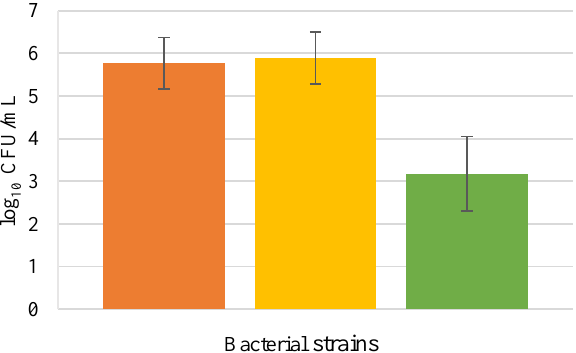
Figure 2. Probiotic bacteria invasion of HaCat cells in Lacticaseibacillus rhamnosus ( ■ ), Lactobacillus delbrueckii subsp. bulgaricus ( ■ ), and Propioniferax innocua ( ■ ). Error bars are ± standard deviation. In co-cultures (Figure 3), E . coli showed no ability to invade keratinocytes in the pres- ence of probiotic bacteria; but this result could be related to the inoculum concentration. The initial counts were higher and the obtained values for E . coli invasion were not detectable (below the method’s detection limit). However, also, the possible probiotic inhibition effects on E. coli must be considered, since both Lactobacillus strains used in this study, especially L. rhamnosus , had been reported to prevent E . coli infection in the gastrointestinal tract [29].